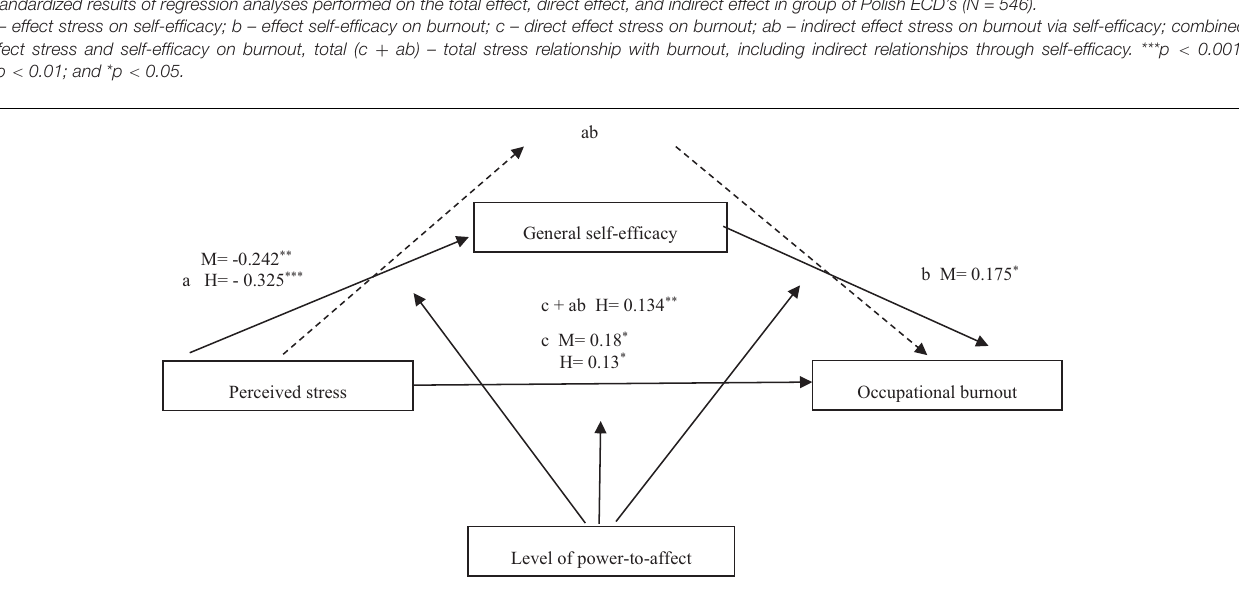
Frontiers in Psychology |